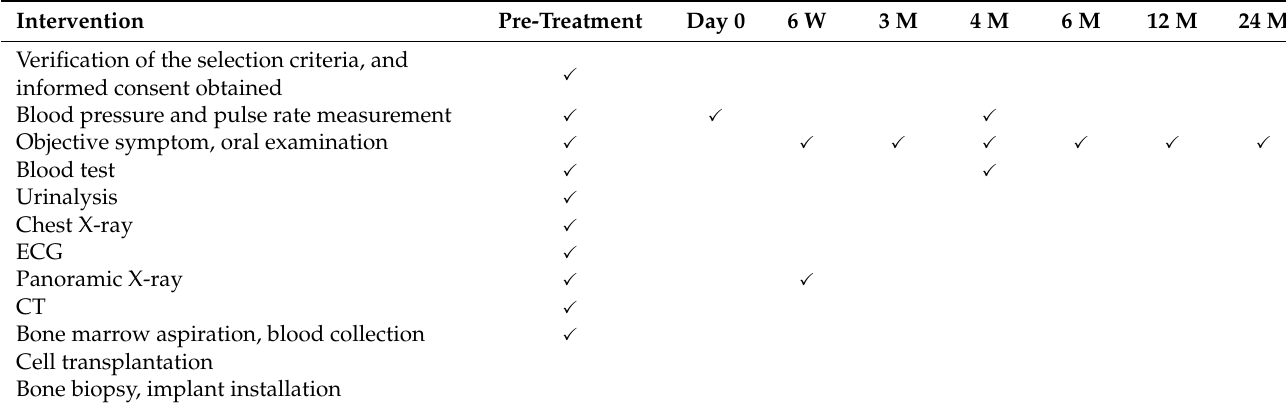
Abbreviations: ‘ACIP’, Advisory Committee on Immunization Practices; ‘CoV’, Committee on Vaccinations; ‘CTV’, Technical Vaccination Commit- tee; ‘HAS’, Haute autorité de santé; ‘HTA’, health technology assessment; ‘JCVI’, Joint Committee on Vaccination and Immunisation; ‘KCE’, Healthcare Knowledge Centre; ‘NACI’, National Advisory Committee on Immunization; ‘PBAC’, Pharmaceutical Benefits Advisory Committee; ‘PHARMAC’, Pharmaceutical Management Agency; ‘S.A.’, sensitivity analysis/supplementary analysis; ‘STIKO’, Standing Committee on Vaccina- tion; ‘TLV’, Dental and Pharmaceutical Benefits Agency; ‘ZIN’, Zorginstituut Nederlands. 1. PBAC provides for costs/savings or socially relevant health or other relevant outcomes are broader than the treated patient population (e.g., community, carers, dependants). 2. STIKO guidance provides for uncertainty analysis from a social health insurance (SHI) perspective whereby transfer payments from insurer to patient are included in analysis. It also considers productivity costs to patients and caregivers in uncertainty analysis. 3. TLV guidance and decision making provides for consideration of healthcare system consequences including secondary complications, enablement, risk compensation, anti-microbial resistance, healthcare capacity; societal consequences including productivity loss of patients and caregivers, formal caregiving, and transportation costs. Not necessarily part of economic analysis, but able to be considered include value of risk reduction, macroeconomic impacts, and societal quality of life impact. 4. The JCVI adopts the evaluation methods of NICE. The NICE perspsective is that of the Natioinal Health Service (NHS) and personal social services (PSS), e.g.,residential care and social worker costs. In exceptional circumstances when requested by the Department of Health and Social Care in the remit for the evaluation, the scope will list requirements for adopting a broader perspective on costs. 5. Canada’s NACI Guidelines for reporting model- based economic evaluations of vaccination programs in Canada guidance on perspective notes, ‘publicly funded health system and societal at mini- mum, with societal considerations inclusive of, ‘productivity losses, consumption, and costs and outcomes of non-health sectors.’ CADTH HTA guidelines adopt the public payer perspective in the reference case, but allow additional societal based considerations, including patient and fam- ily/carer productivity, education and civic outcomes, time, and travel costs, as well as non-health payer outcomes (e.g., different government depart- ments) as additional non-reference case analyses. 6. In the Netherlands, the Committee on Vaccinations (under the Health Council) advises the Min- ister of Health, Welfare and Sport about public vaccination programs. It has 7 assessment criteria for inclusion of a vaccine in a public programme, one of which is economic. Although it does not specify perspective, ZIN, responsible for economic evaluation in the Netherlands to determine health insurance coverage, uses a societal perspective, which can include patient and family costs (e.g., costs of informal care) and productivity costs. 7. Although not required, the CTV can commission a full economic analysis. The CTV engages with the HAS. For the purposes of comparison, HAS HTA Guidelines have been assumed. The relevant HTA advisory body, National Authority for HTA (Comité Economique des Produits de Santé)